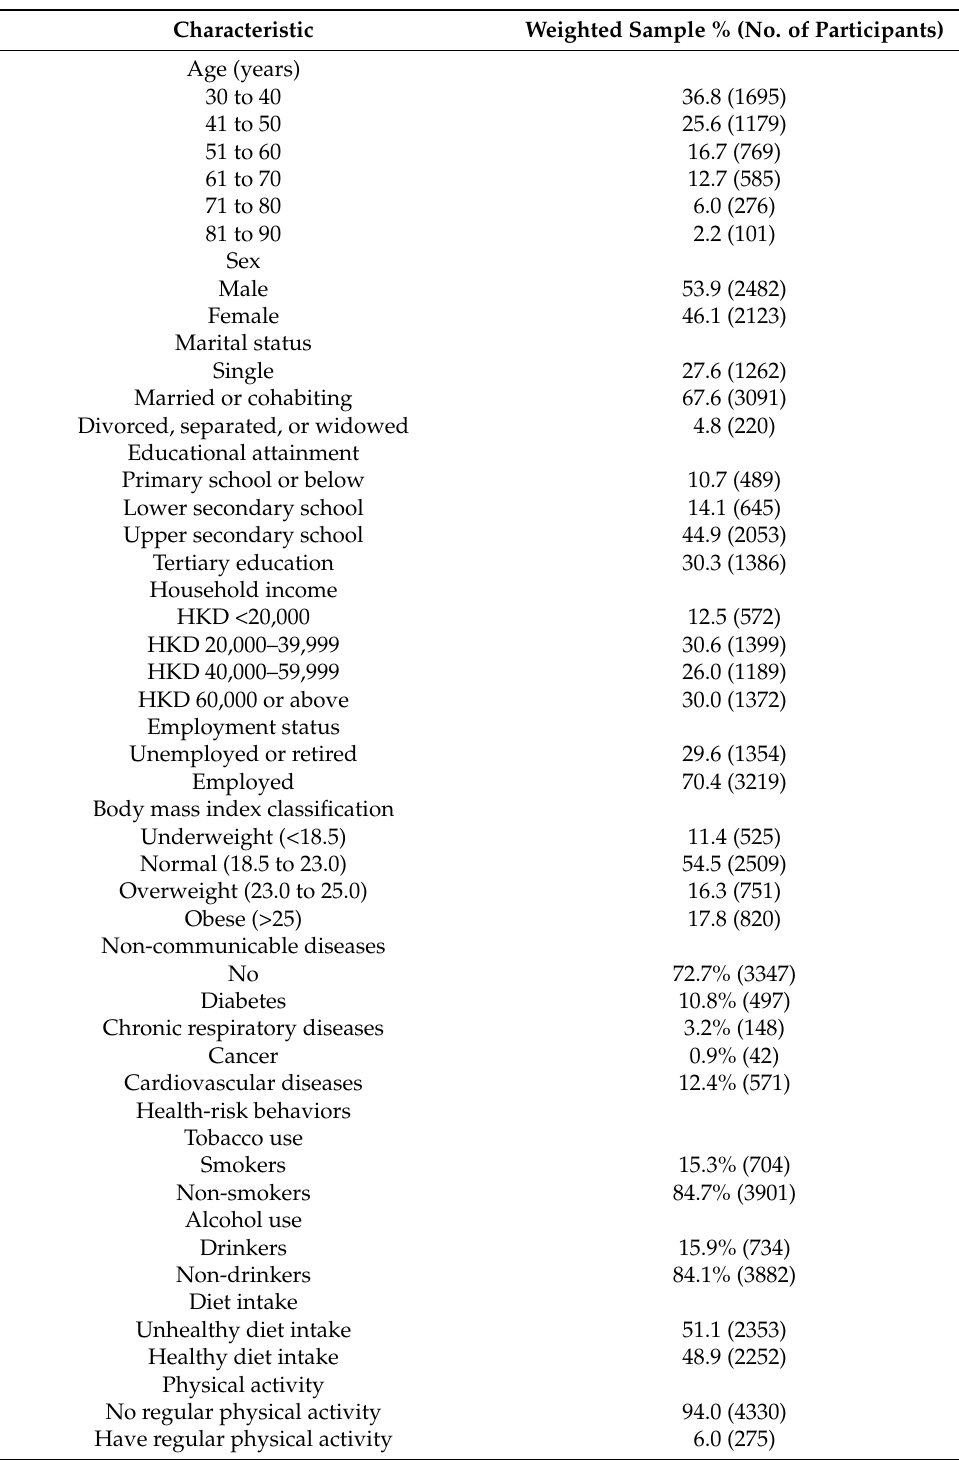
Table 1. Demographic characteristics of the participants with at least one health-risk behavior ( N = 4605) a